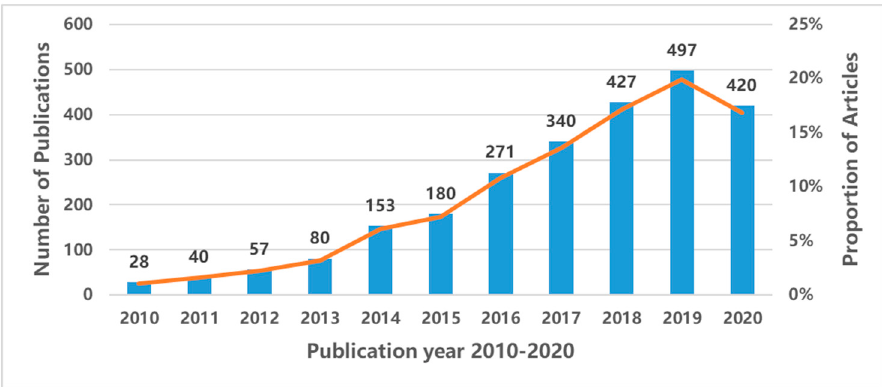
Figure 2. Trend of publication in Social Media Big Data (SMBD).